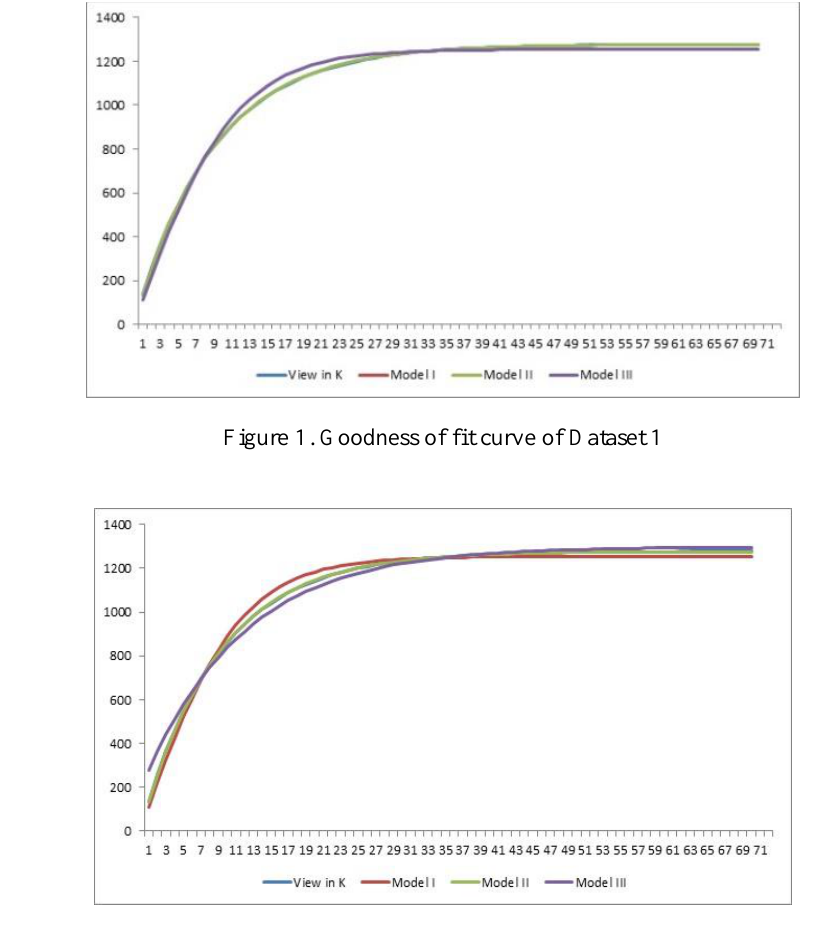
Figure 2. Goodness of fit curve of Dataset 2